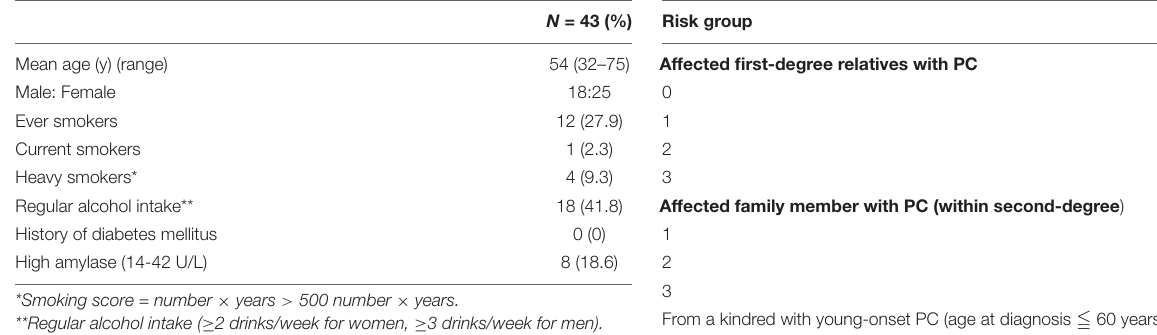
TABLE 1 | Characteristics of high-risk individuals undergoing screening. TABLE 2 | Family history of pancreatic cancer and personal history of any cancer.